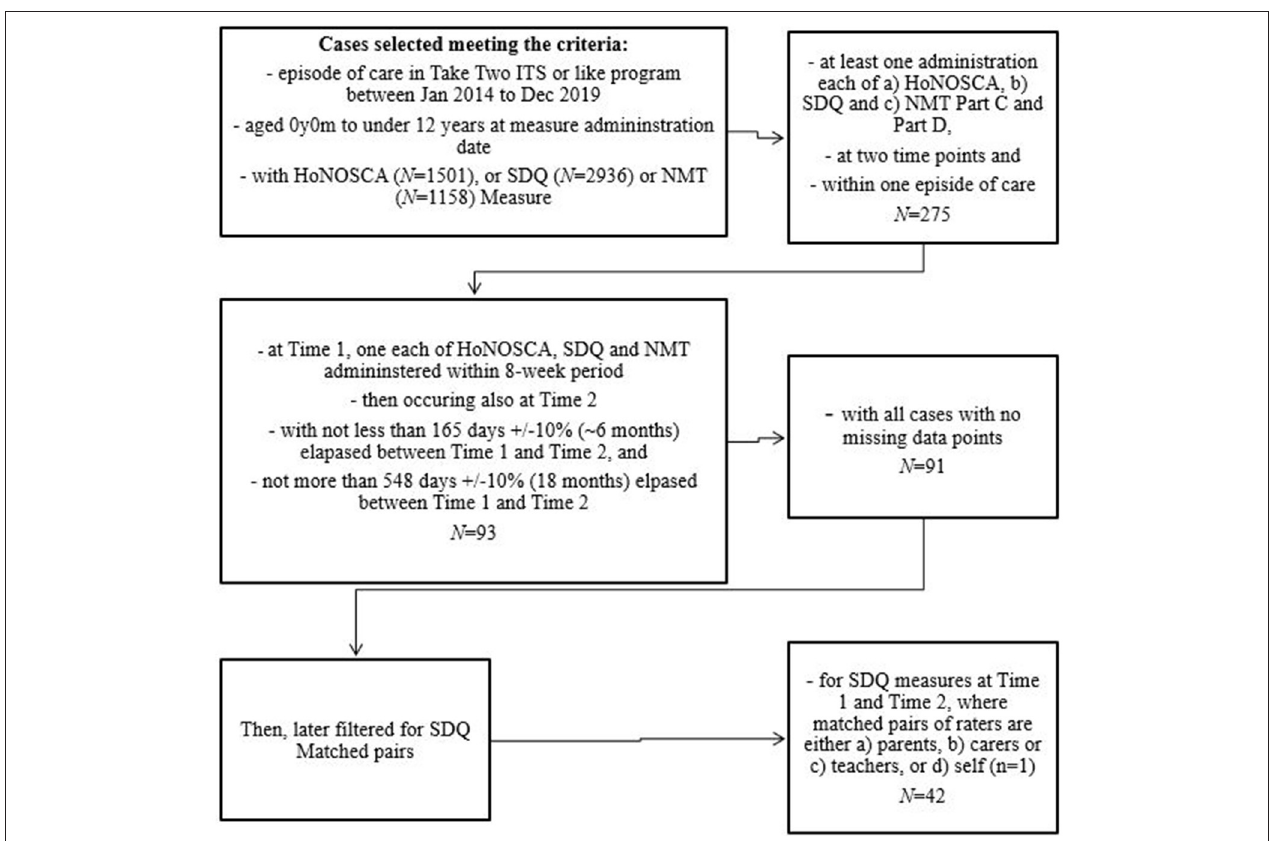
FIGURE 2 | Sample selection flow